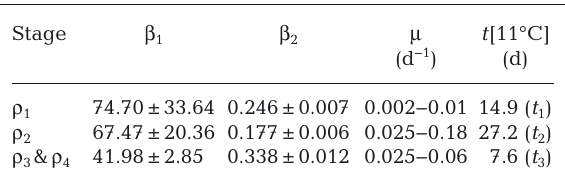
Table 1. Development time (t) and mortality ( μ ) for chalimus ( ρ 1 ), pre-adult ( ρ 2 ), adult ( ρ 3 ) and gravid ( ρ 4 ) stages. De - velopment time or stage length t , at 11°C, T , is found by using the equation: t ( T ) = [ β 1 /( T − 10 + β 1 β 2 )] 2 (Stien et al. 2005), where β 1 and β 2 are shape Stage β 1 β 2 μ t [11°C] (d −1 ) (d) ρ 1 74.70 ± 33.64 0.246 ± 0.007 0.002−0.01 14.9 ( t 1 ) ρ 2